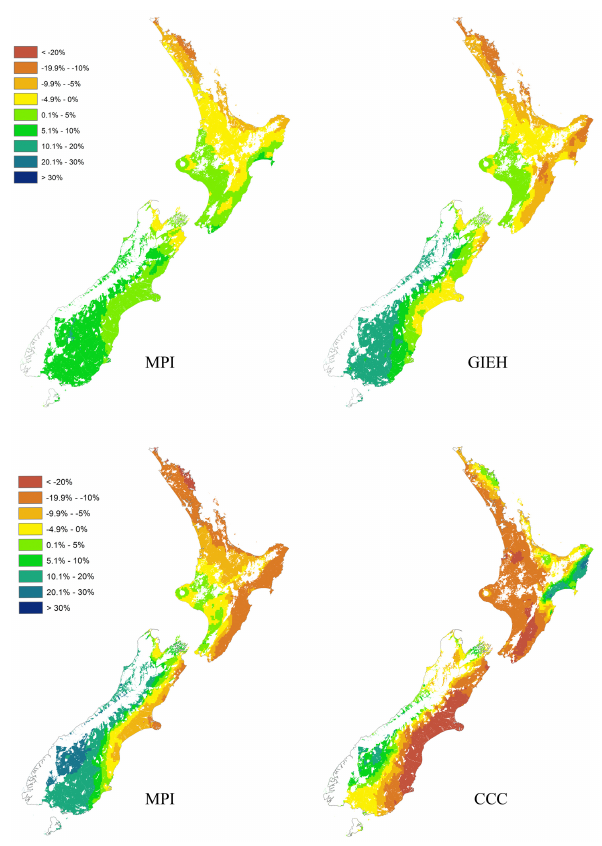
Figure 10. Total annual change in precipitation in 2050 (top) and 2100 (bottom), percentage change from baseline, for MPI (left) and GIEH/CCC (right) climate change